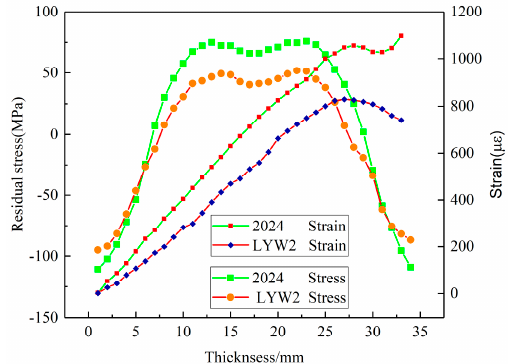
Figure 15. Residual stresses of 2024Al and W/2024Al samples quenched in 60 °C water measured using the crack-compliance method.